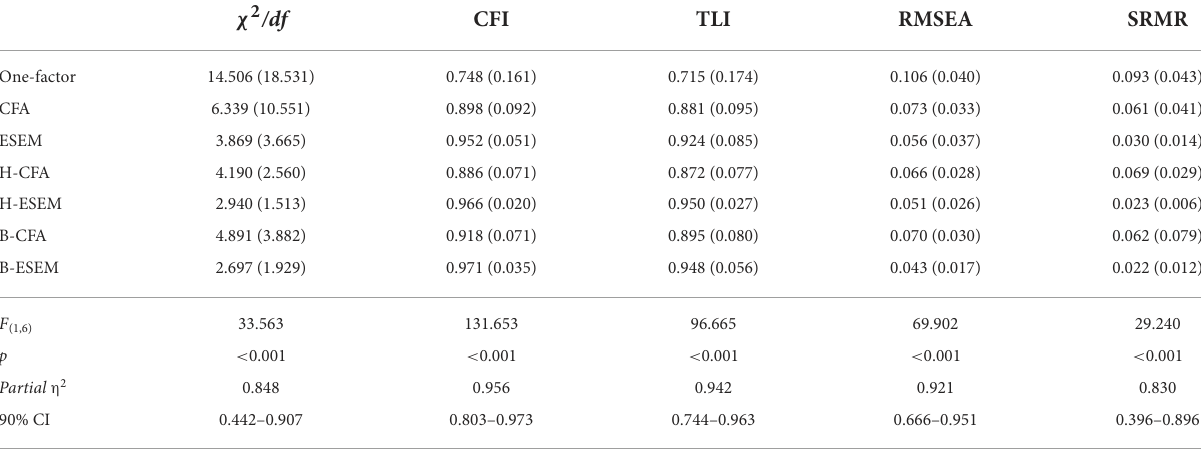
TABLE 6 Mean (and standard deviation) estimates of the goodness-of-fit indices per